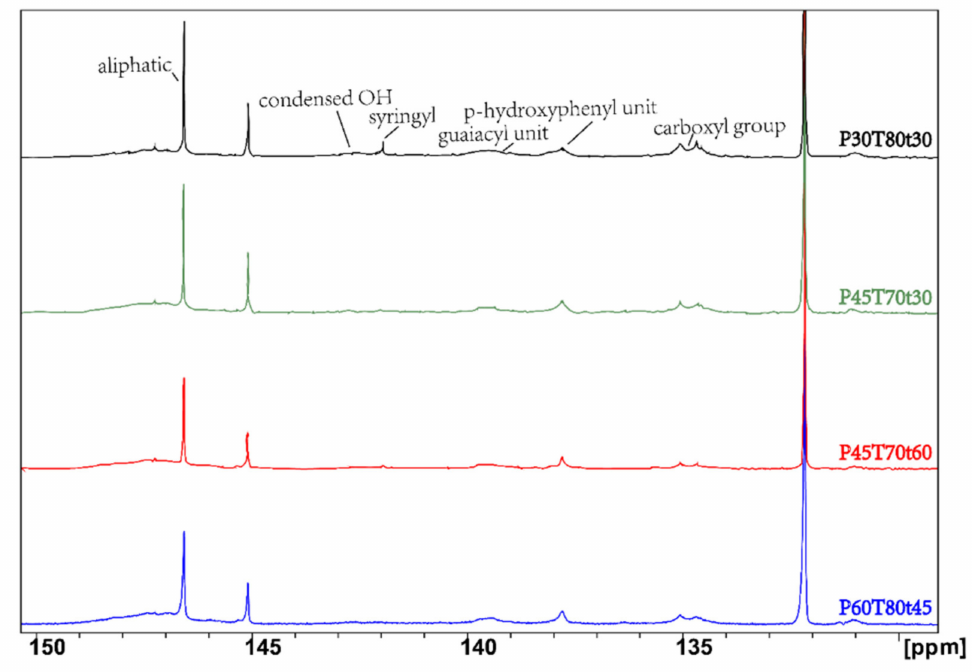
Figure 7. 31 P NMR spectroscopy of selected lignin samples in comparison. From top to bottom: P30T80t30, P45T70t30, P45T70t60, P60T80t45.